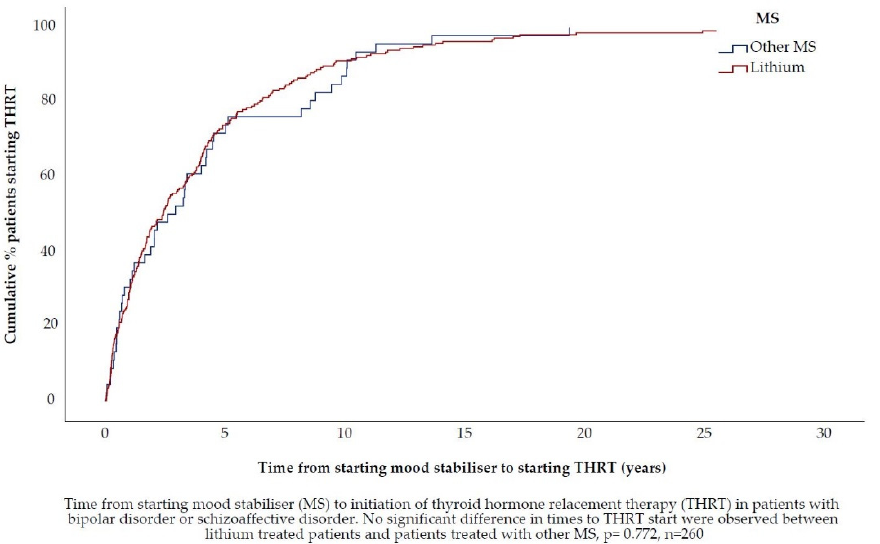
Figure 8. Time from starting Mood Stabiliser to initiating Thyroid Hormone Replacement Therapy, stratified by Mood Stabiliser.